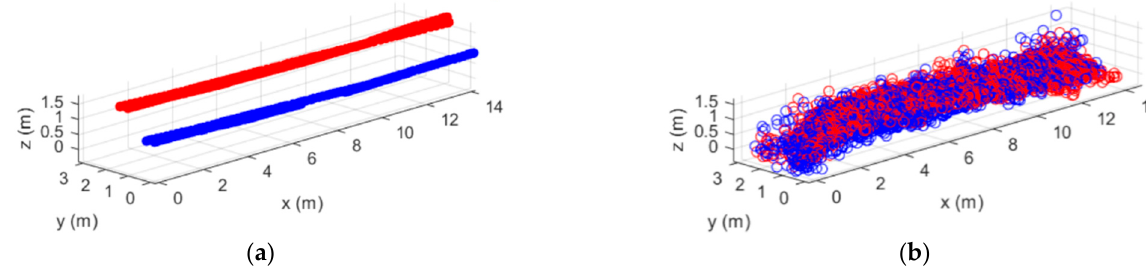
Figure 8. ( a ) Rover modules positions and ( b ) point cloud retrieved from a round trip scanning path.